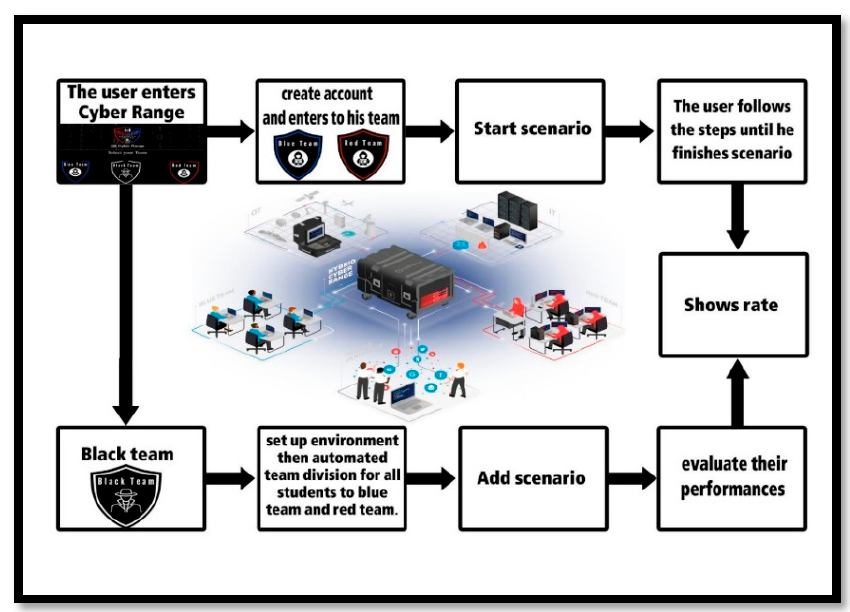
Figure 2. The flowchart of the proposed system.